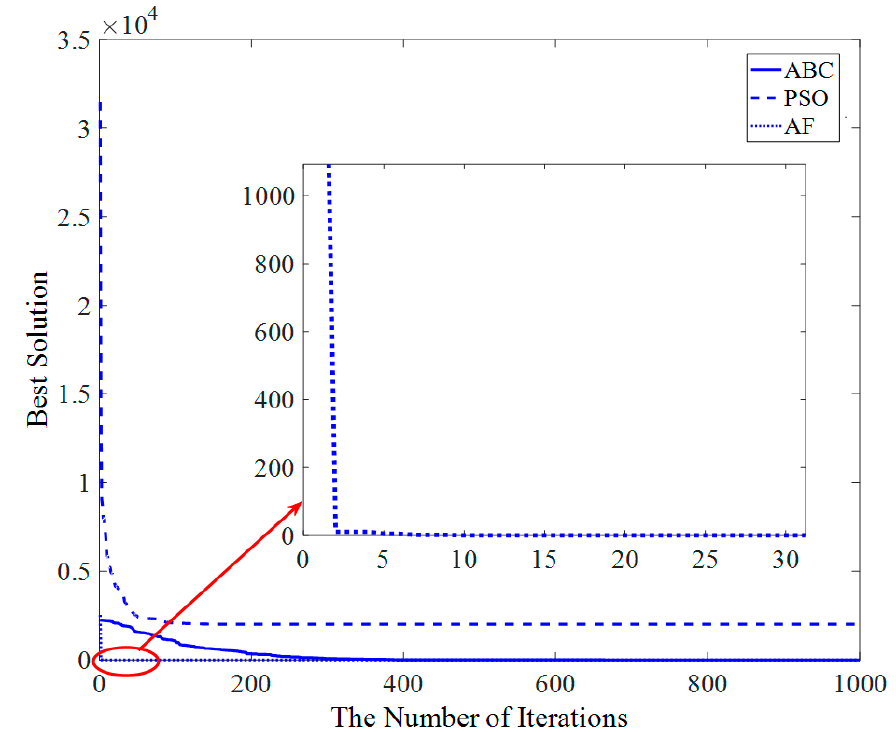
Figure 19. The convergence curve of the three algorithms for Griewank function in 100-dimensional space.